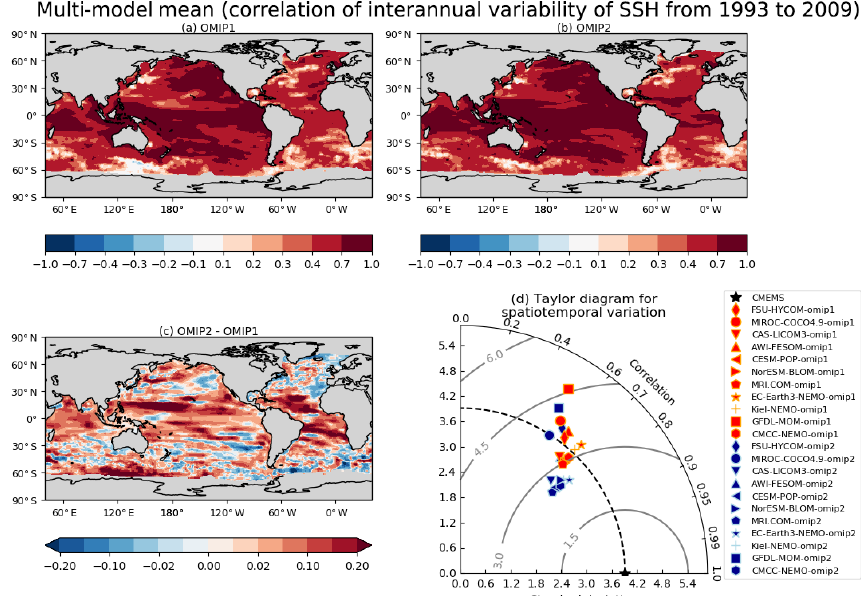
Figure E4. Multi-model mean correlation coefficients of monthly SSH anomaly relative to the monthly climatology for the period 1993– 2009 between simulation and CMEMS. (a) OMIP-1, (b) OMIP-2, (c) OMIP-2 − OMIP-1. (d) Taylor diagram of the total space–time pattern variability of monthly SSH anomaly relative to the monthly climatology for OMIP-1 and OMIP-2 simulations relative to CMEMS, with standard deviations expressed in units of centimeters. See Figs. S58–S60 for results of individual